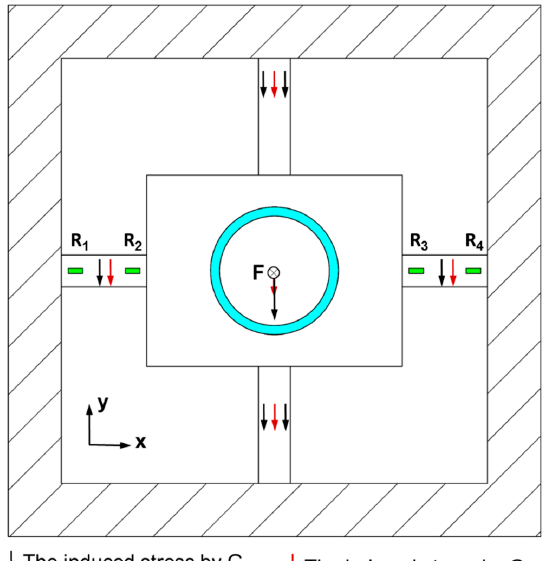
Figure 5. Arrangement of the piezoresistors.